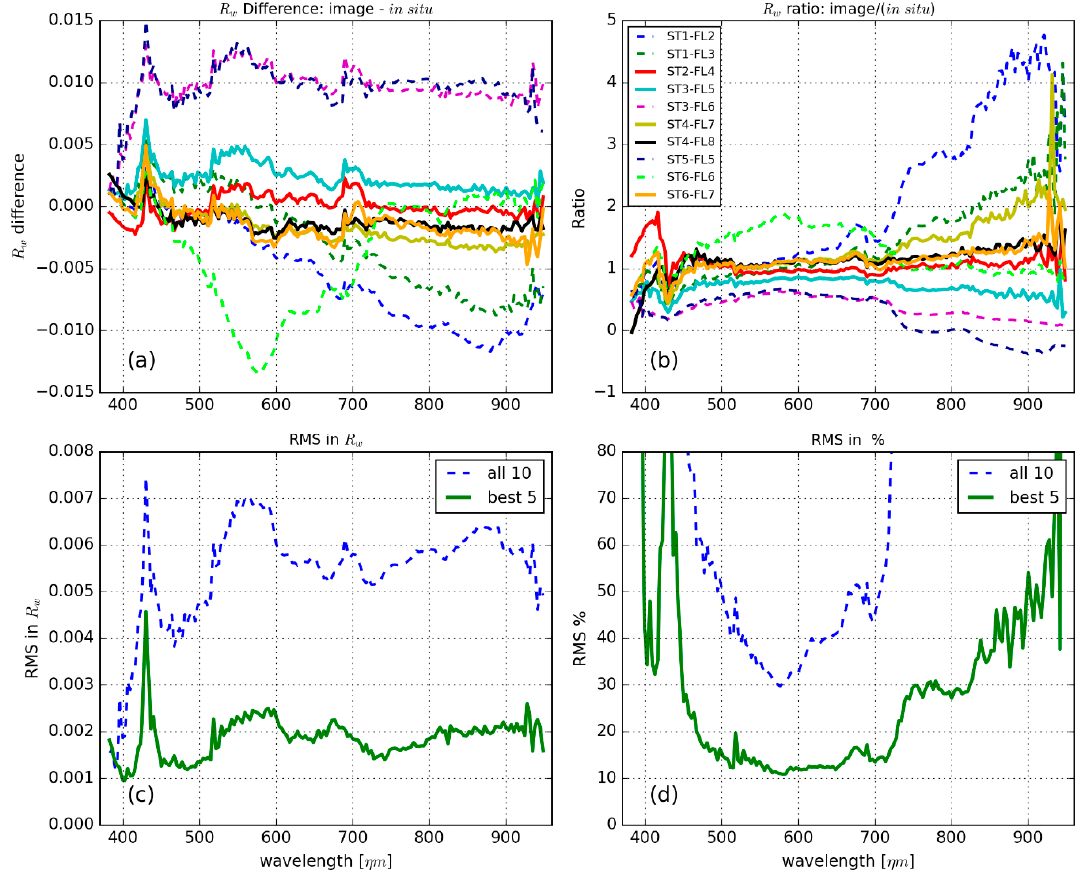
Figure 7. ( a ) Difference between image-derived and in situ R w ; ( b ) ratio of in situ over image-derived R w ; ( c ) RMS of the best five and all matchups, respectively, in units of reflectance; ( d ) Relative RMS. Matchup labels for panes ( a , b ) are given in the legend of panel ( b ), and the five best matchups are plotted with a solid line.